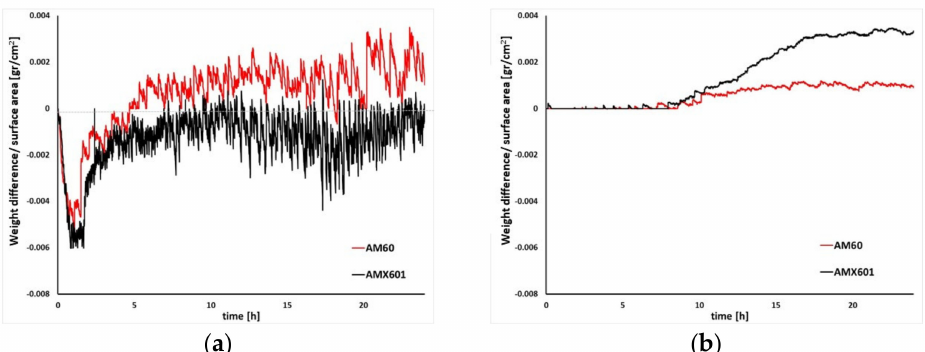
Figure 14. Gravimetric measurement ( ∆ W/A) for AM60 and AMX601 alloys immersed in: ( a ) 3.5 wt% NaCl solution saturated with Mg (OH) 2 ; ( b ) NaOH solution during 24